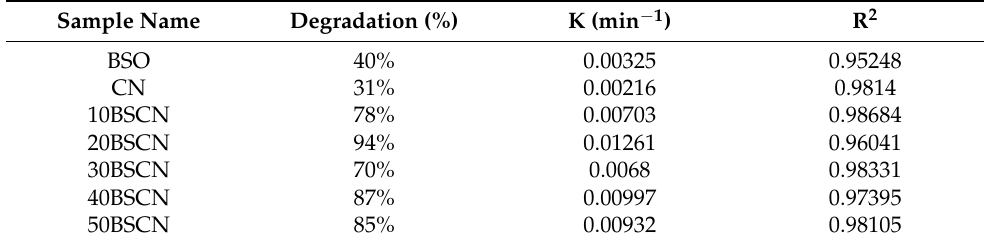
Figure 8. Photocatalytic degradation performance of NOR by BSO, CN, and BSCN heterojunction photocatalysts under visible light ( a ); kinetic curves of NOR degradation ( b ). Table 1. Photocatalytic performance of as-prepared samples.